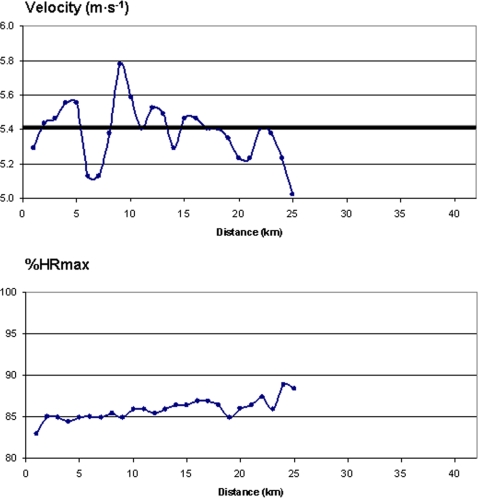
Running velocity (top) and % of maximal heart rate (%HRmax) (bottom) in an experienced marathon runner (best performance = 2 h 15 min) who was attempting to run at 2 h 10 min pace (which corresponds to the mean speed marked with a bold horizontal line in the upper Figure) until he had to drop out at 25 km.Note that his %HRmax continued to increase until he dropped out of the race, indicating that despite slowing his running velocity, his relative effort was still increasing throughout the run.